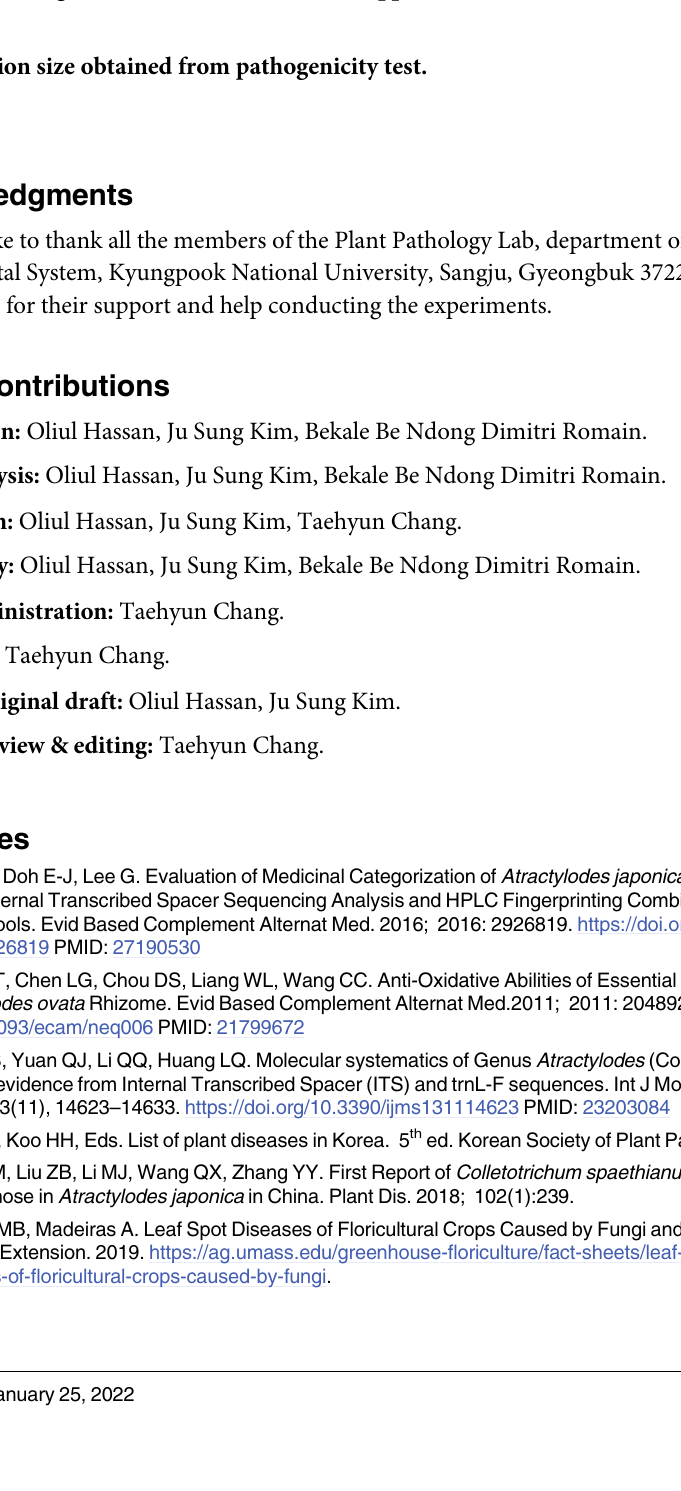
S3 Table. Comparison of morphological characteristics of close species from the Colletotri- chum magnum